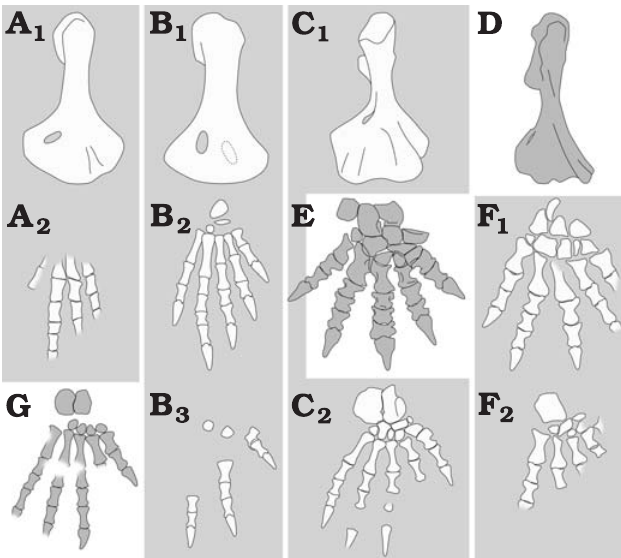
Fig. 7. Drawings of appendicular elements of selected Caseasauria: humeri (A 1 –C 1 , D), manus (A 2 , B 2 , E, F 1 ), and pedes (B 3 , C 2 , F 2 , G). A . Datheo- saurus. B . Callibrachion. C . Casea , refers to C. broilii . D . Oedaleops . E . Euromycter . F . “ Casea ” nicholsi (from Olson 1968: fig. 18G, H). G . Eocasea . Compiled from: C, UC 657 (FS personal observation) and UC 656 (after Romer and Price 1940: fig. 41H); D, Sumida et al. (2014); E, Sigogneau-Russell and Russell (1974); F, Olson (1954, 1968); G, Reisz and Fröbisch (2014). Not to